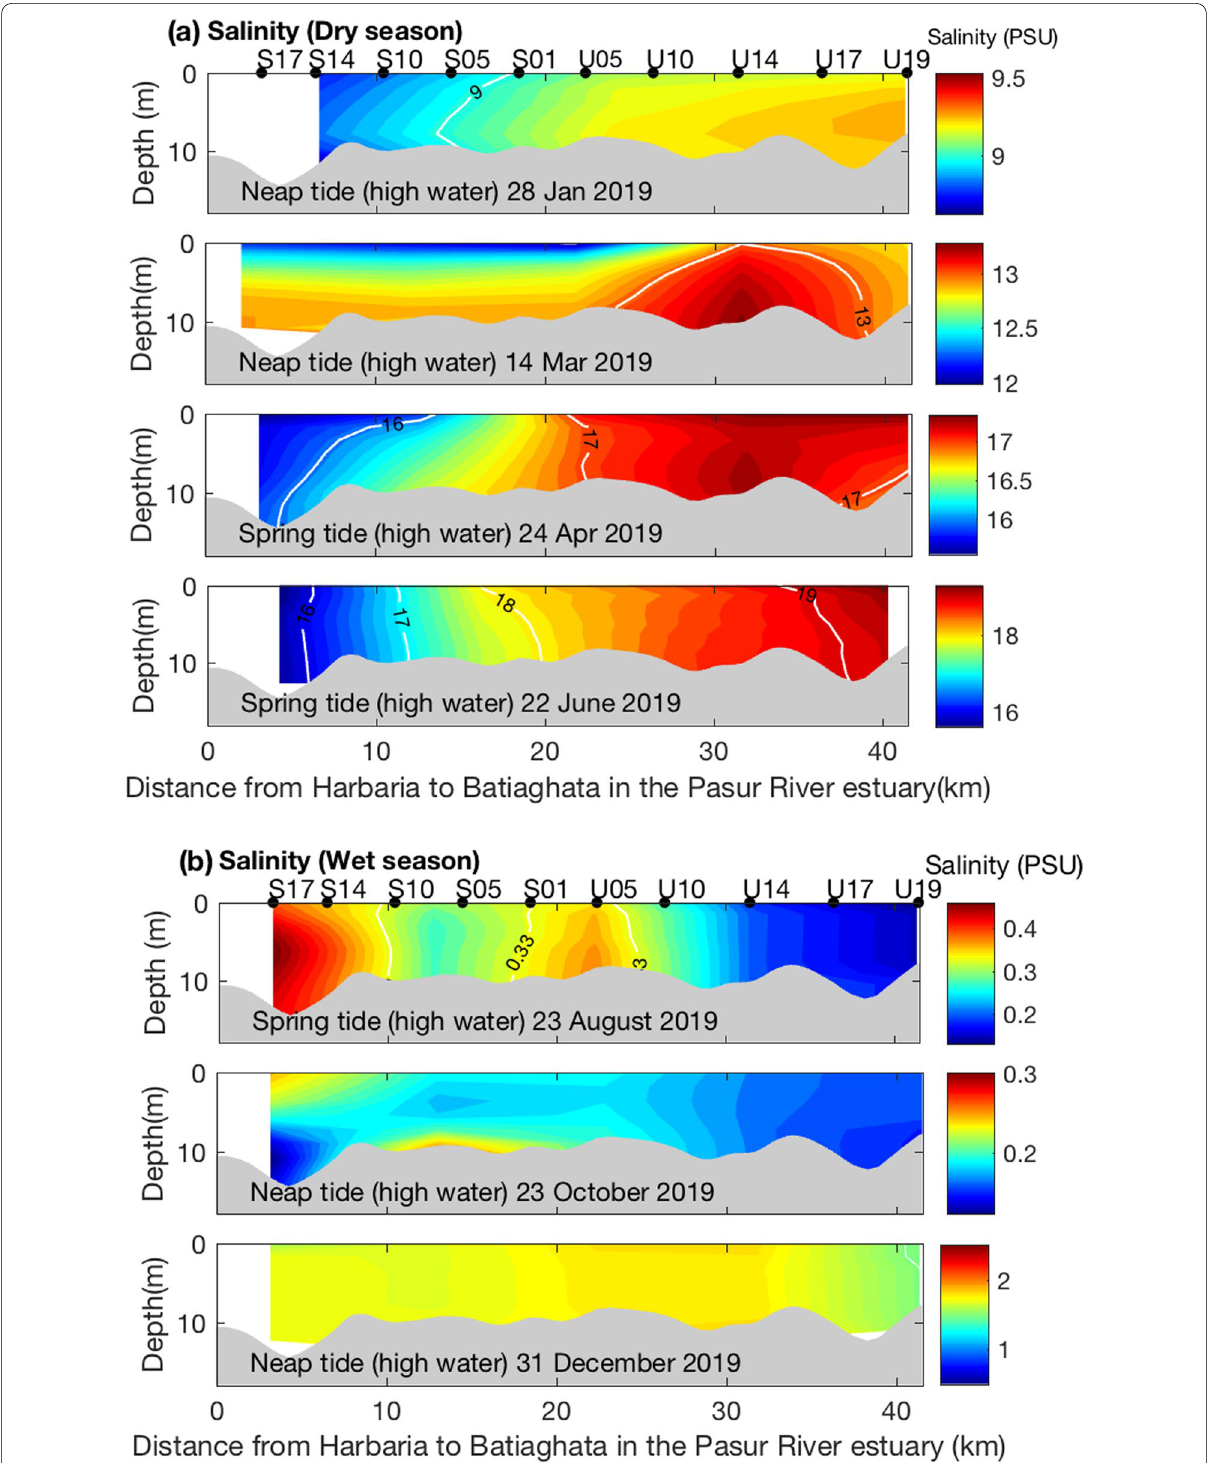
Fig. 6 Vertical salinity distribution at high water in the Pasur River Estuary during spring and neap tides in the dry and wet seasons. Salinity maximum zone (salt plug area) is approximately denoted as SP (25 ~ 45 km) and downstream of salt plug area is denoted as DSP (< 20